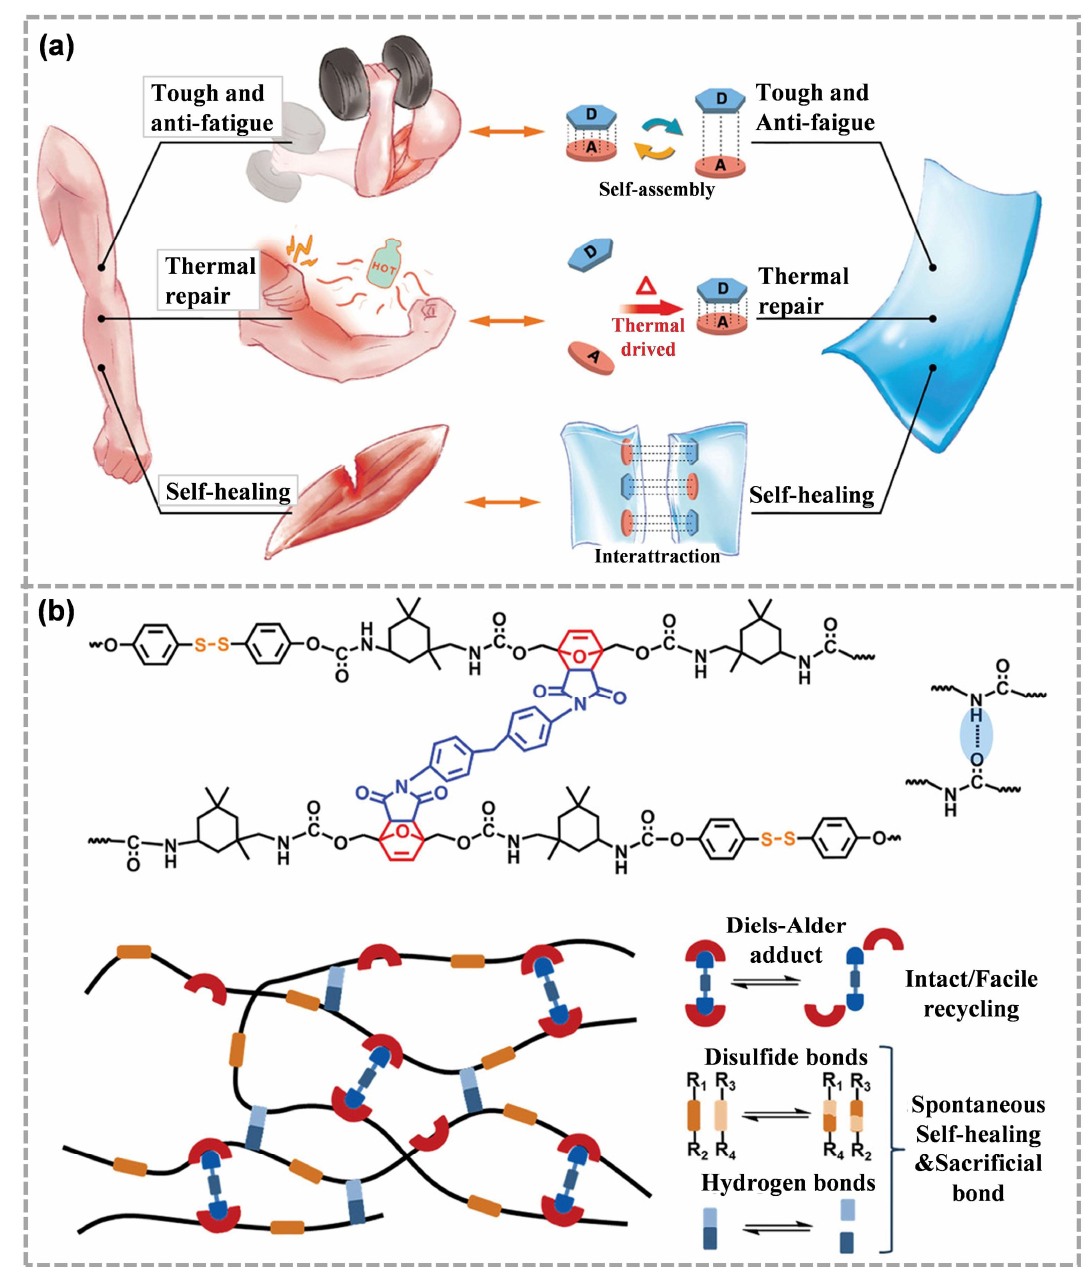
Figure 10. ( a ) Schematic diagram of muscle-inspired polyurethane-based donor-acceptor self-assembly (reproduced from Ref. [48] with permission; Copyright Wiley, 2021), ( b ) molecular structure and schematic structure of polyurethane including reversible covalent crosslinks based on Diels–Alder adducts, disulfide bonds and hydrogen bonds (reproduced from Ref. [134] with permission; Copyright Wiley, 2021).